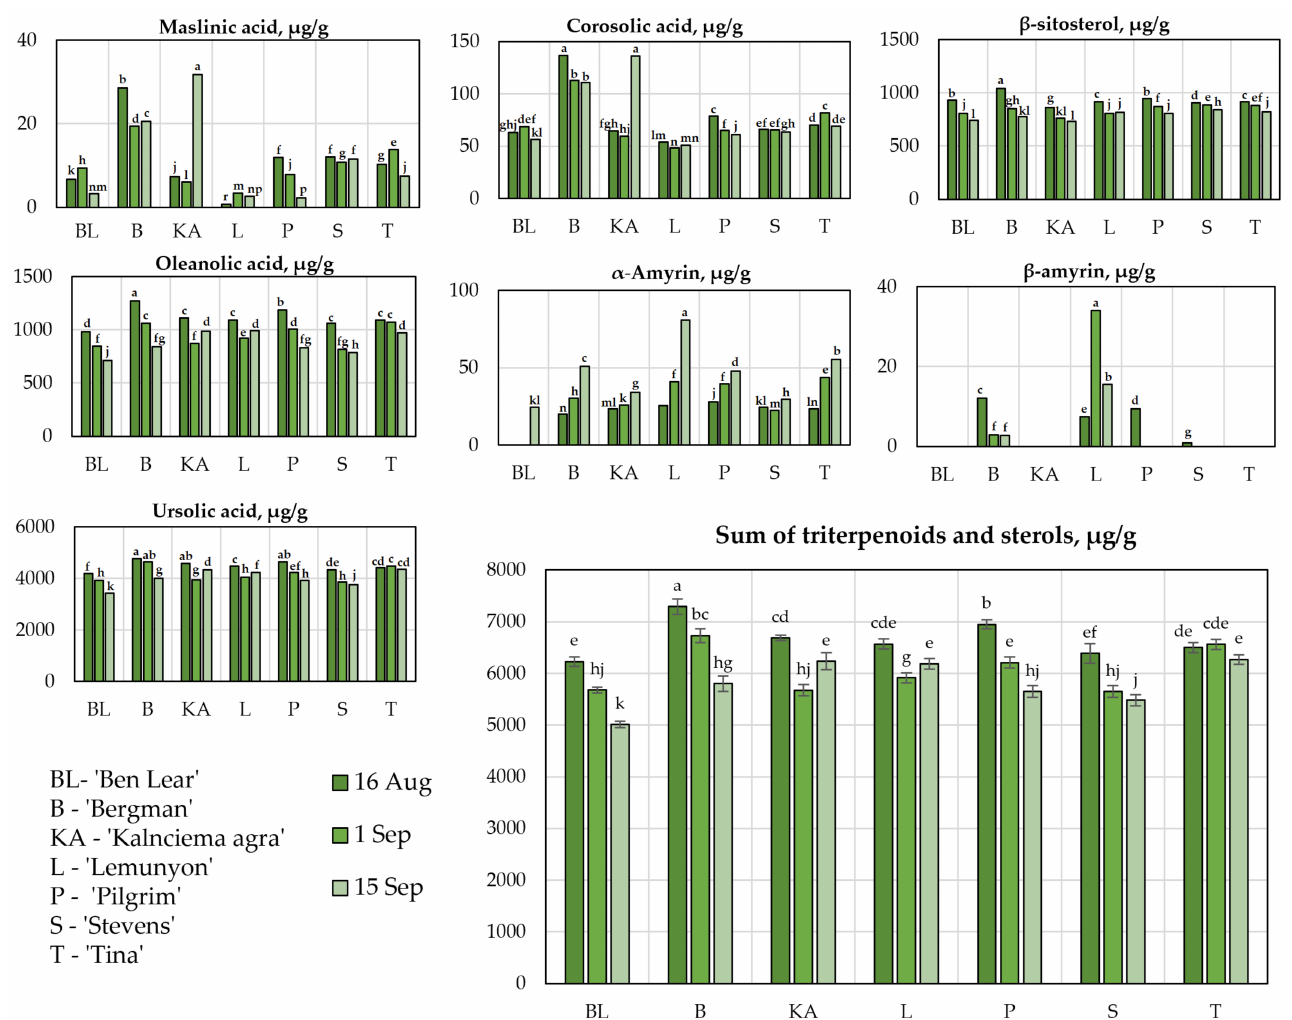
Figure 4. Variability in the qualitative and quantitative compositions of triterpene compounds in the fruit samples of the large cranberry cultivars. Different letters indicate statistically significant differences between the detected total amounts of the triterpene compounds in the cranberry fruit samples ( p <